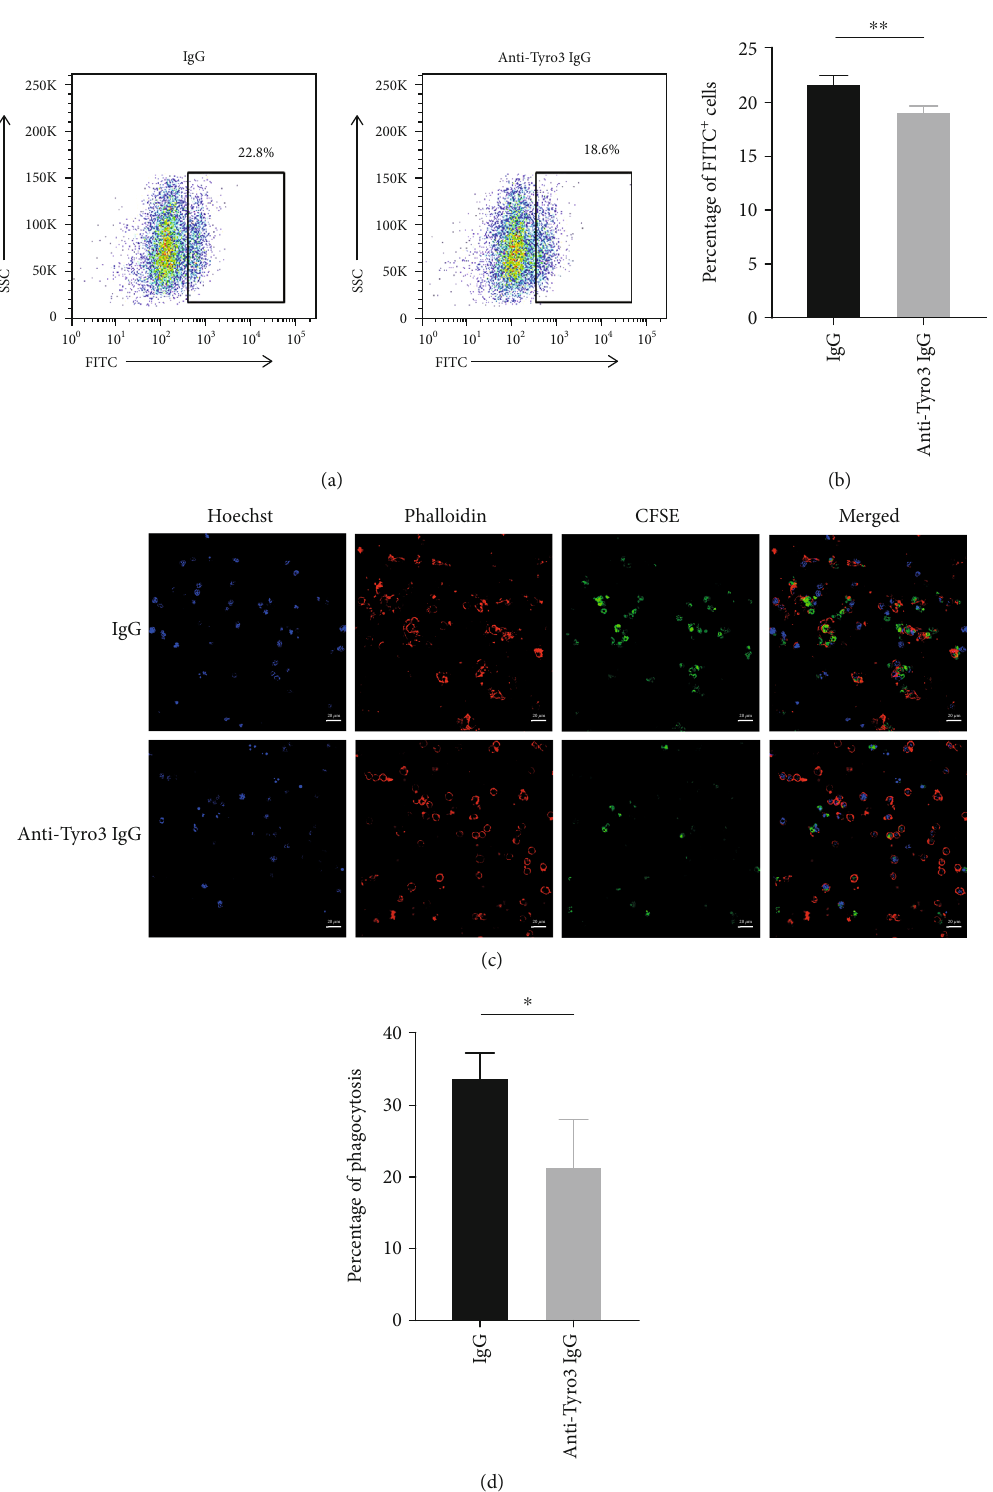
Figure 4: Autoantibody against Tyro3 receptor reduced macrophage e ff erocytosis by fl ow cytometry and immuno fl uorescence. (a) The e ff erocytosis of macrophages was analyzed by fl ow cytometry. (b) The statistical graph showing the fl ow cytometry data ( n = 4 ). The values represent the mean ± SD . ∗∗ p < 0 : 01 . (c) Representative photograph of the e ff erocytosis of macrophages monitored by immuno fl uorescence, presented as merged pictures of Hoechst (blue), phalloidin (red), and CFSE (green). Bar, 20 μ m. (d) Statistical data of the percentage of e ff erocytosis in 100x views of the confocal microscope ( n = 3 ). The values represent the mean ± SD . ∗ p < 0 : 05